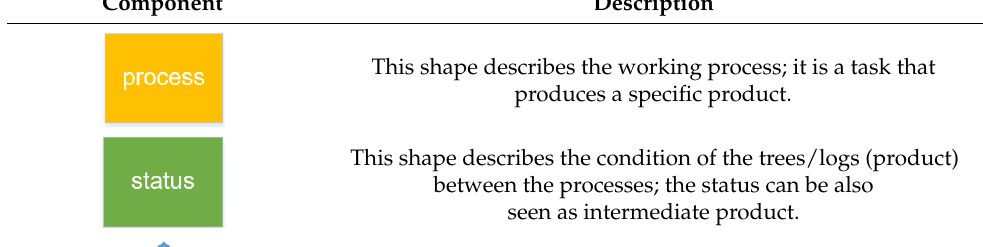
Table 3. Components of the process flow charts defined by different shape types and colors. 151 Component